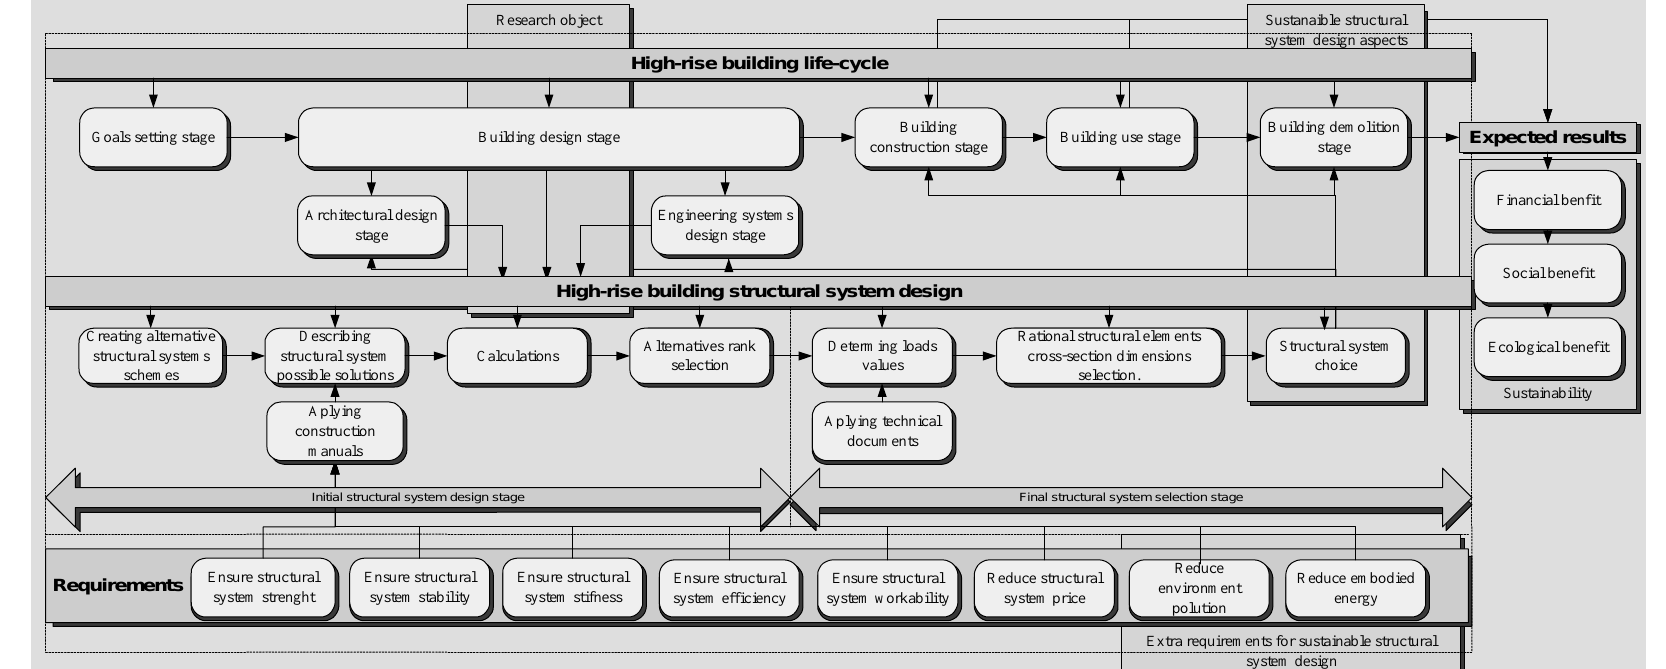
Fig. 2. Complex assessment model of a structural system used in a high-rise